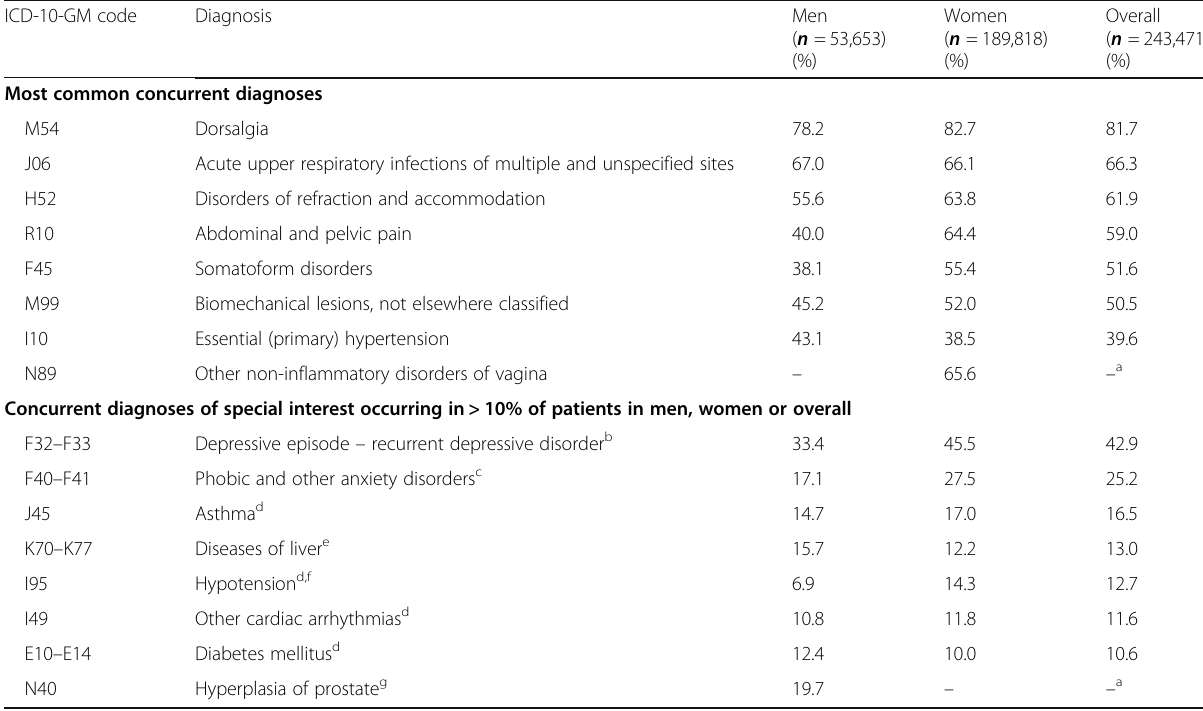
Table 2 Concurrent diagnoses in patients with migraine in the German Company Sickness Fund Database 2008 to 2016 ICD-10-GM code